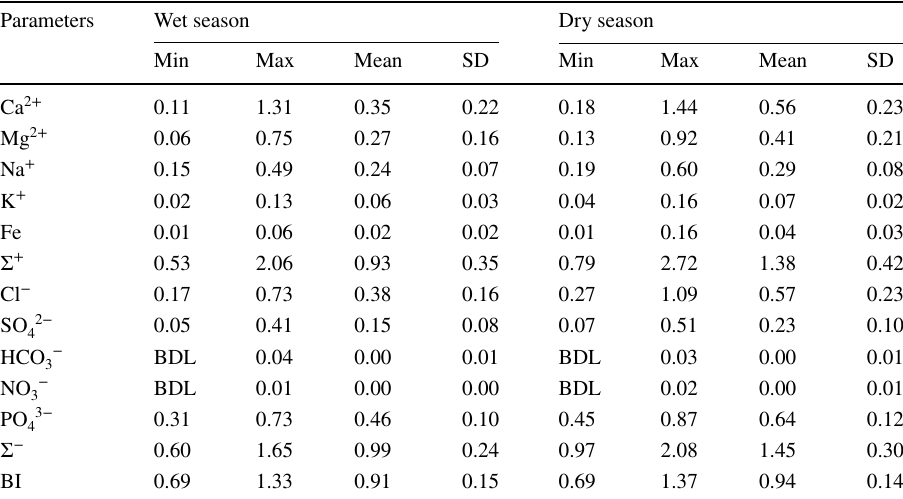
Table 8 Ion balance study for 35 surface water sources of the